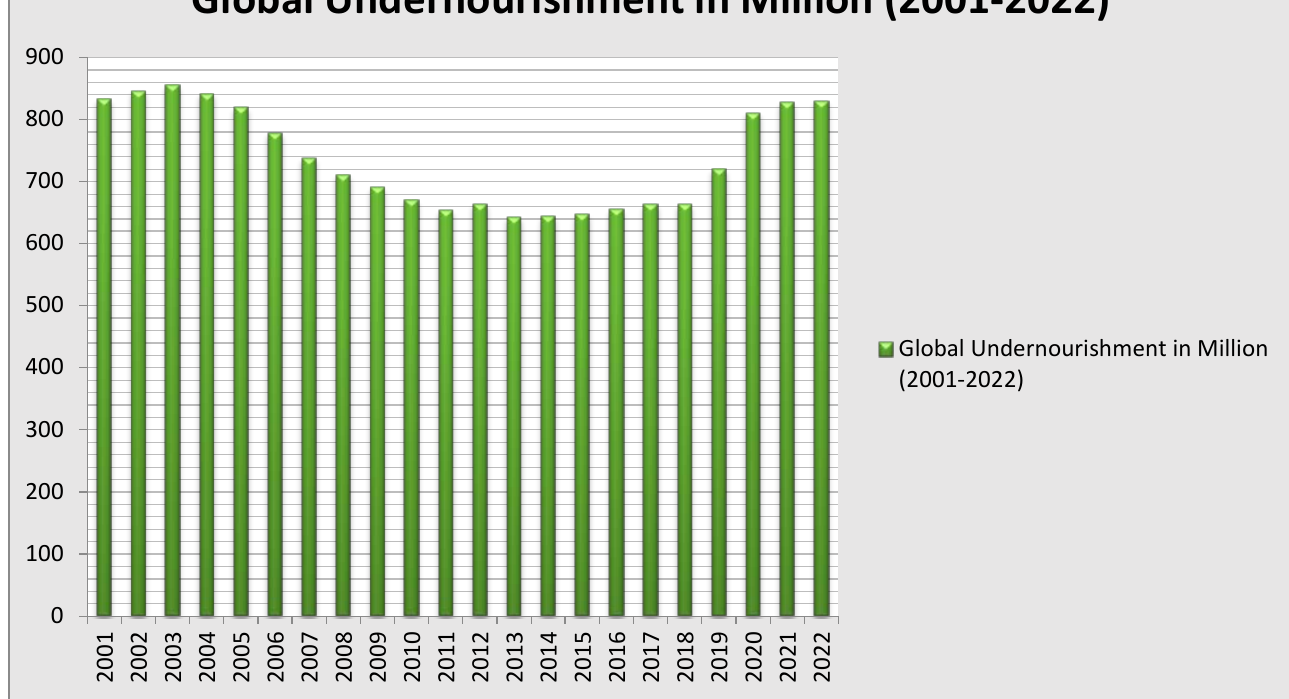
Figure 1. Global undernourishment in millions. Source: World Bank Database, 2022.